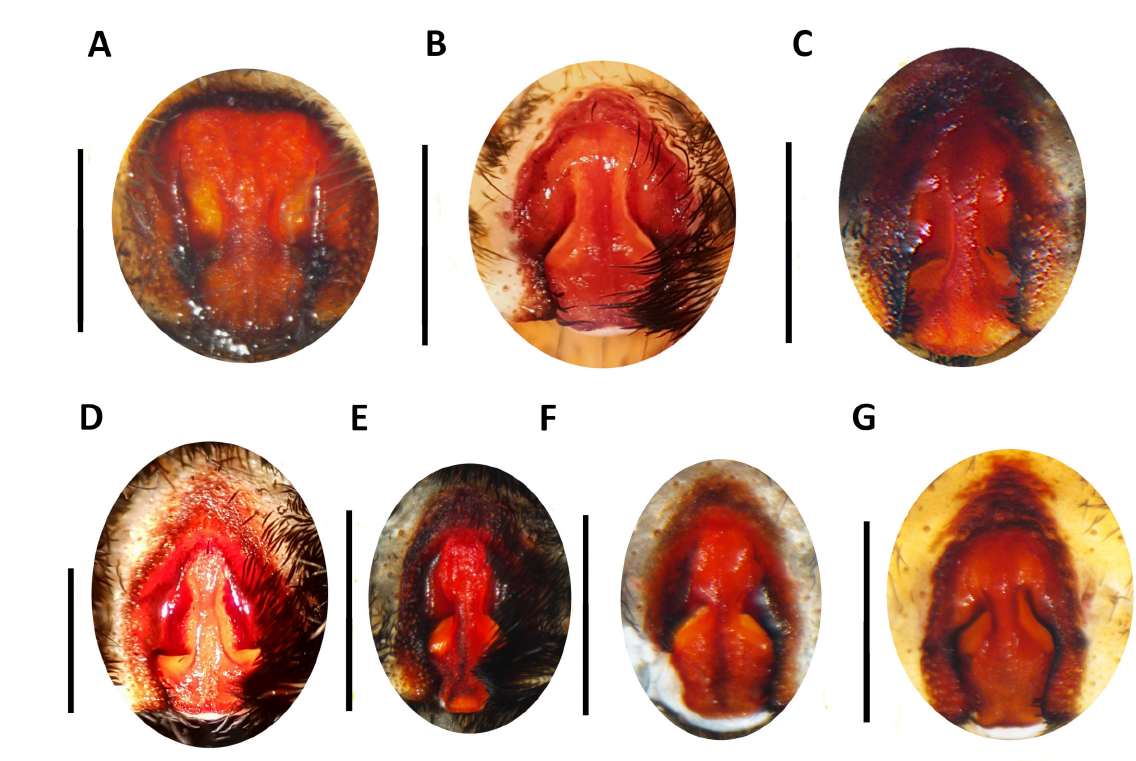
Fig. 27. Lycosa ♀♀ raised in laboratory for more than one molt, possibly aberrant epigynes, ventral view. A . L. hyraculus sp. nov. HUJ INV-AR20665. B–G . Lycosa piochardi Simon, 1876. B . HUJ INV-AR20576. C . HUJ INV-AR20552. D . HUJ INV-AR20668. E . HUJ INV-AR20563. F . HUJ INV- AR20783. G . HUJ INV-AR20549. Scale bars = 0.5 mm. Photos by I. Armiach